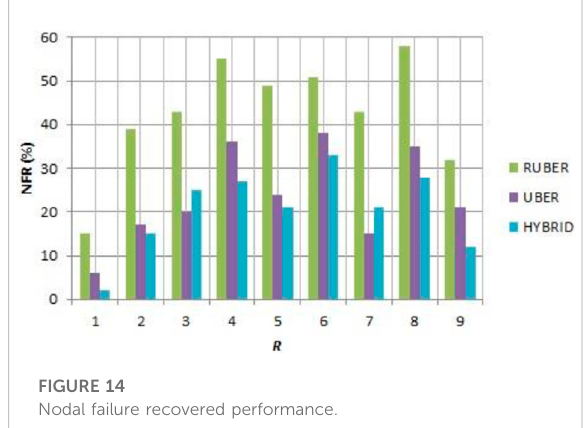
FIGURE 14 Nodal failure recovered